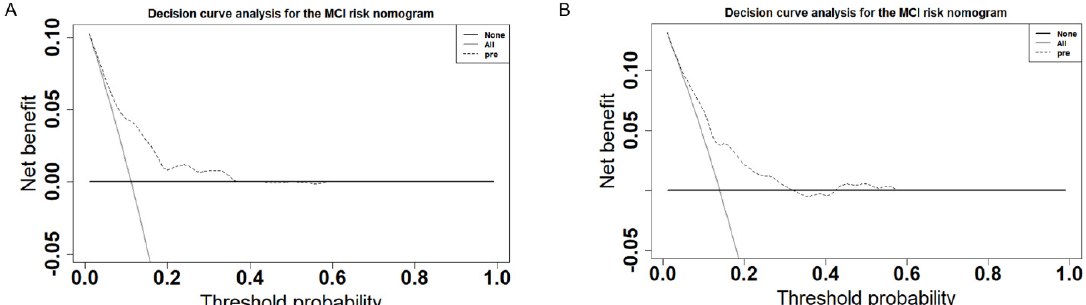
Figure 6. Decision curve analysis for the MCI risk nomogram in the training set ( A ) and in the validation set ( B ). The y − axis measures the net benefit. The thick solid line represents the assumption that no patients have MCI. The thin solid line represents the assumption that all patients have MCI. The dotted line represents the risk nomogram.